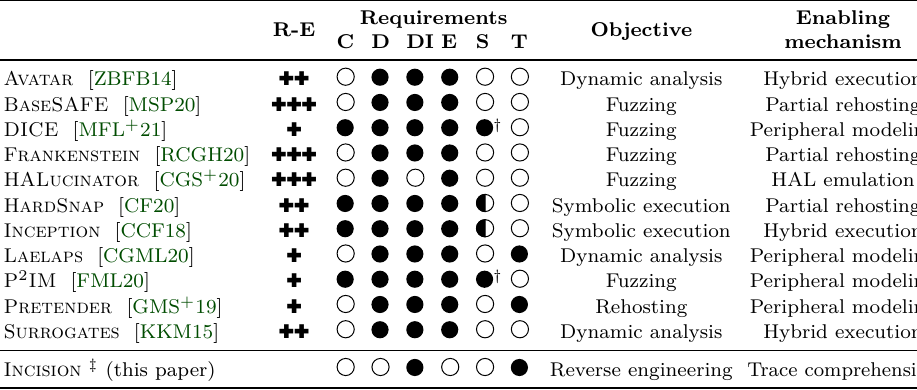
Table 1: Embedded firmware analysis approaches. Amount of prior reverse engineering (R-E) measured by: (cid:58) for identification of interrupts and handlers, stall states, and context switches, (cid:58)(cid:58) for peripheral interaction, cross-core communication, and (cid:58)(cid:58)(cid:58) for specific functionality (for stubbing/harnessing). Requirements refer to target support needed: (C)ompiler, (D)ebugger, (DI)sassembler, (E)mulator, (S)ource Code,